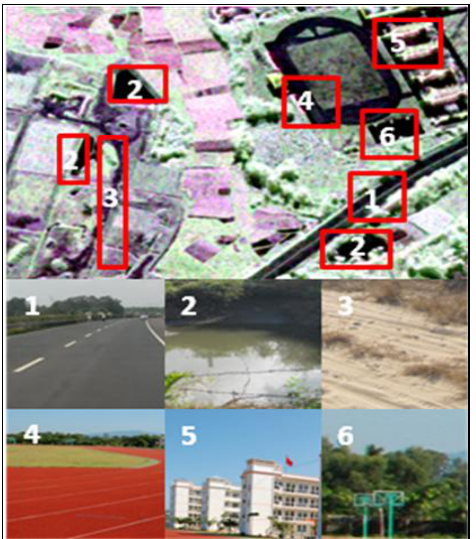
Figure 10. The PAULIRGB image of the XSAR and the corresponding ground truth